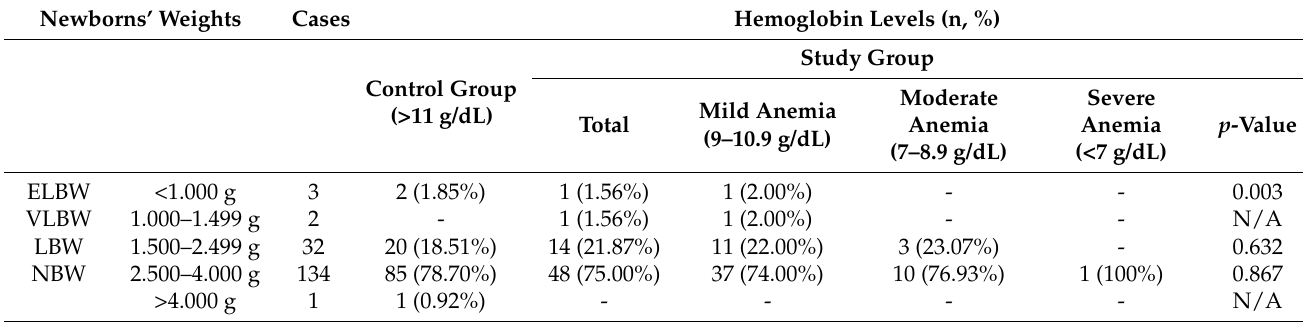
Table 7. Distribution of patients according to newborns’ weights and hemoglobin levels.